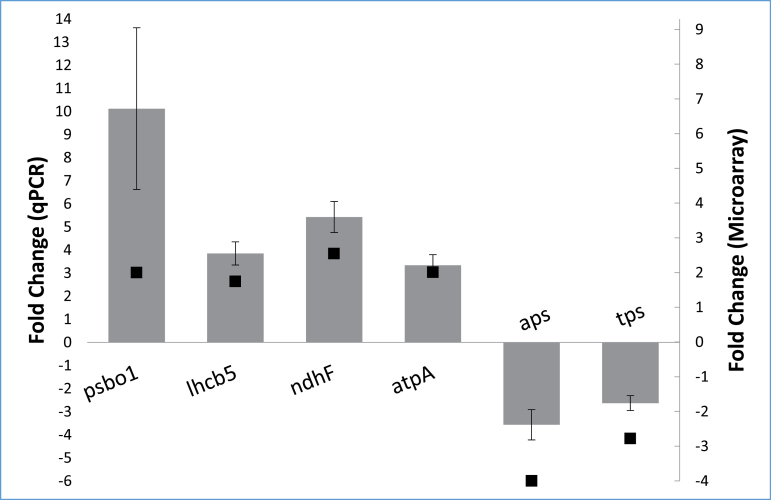
qPCR validation of six transcripts found to be up- or downregulated on the microarray (Table 2): psb01 (oxygen-evolving enhancer protein 1), lhcb5 (chlorophyll a/b-binding protein CP26), ndhF (NADH dehydrogenase F, chloroplast, atpA (ATP synthase alpha subunit), aps (ATP sulphurylase), and tps (terpene synthase). The ΔΔCT method was used to calculate fold-change and all results were normalized against the reference gene tubb6. Grey bars indicate the qPCR-validated fold-change (primary Y-axis) and black squares indicate the microarray fold-change (secondary Y-axis). Error bars represent the standard error of the mean of the biological replicates (n=4).